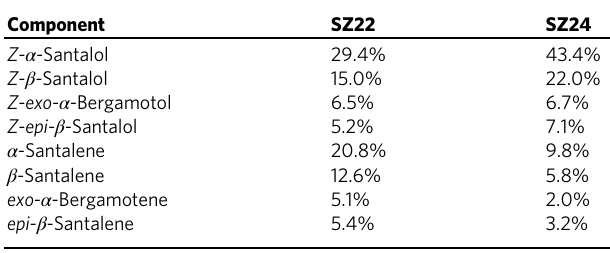
Table 1 The component ratios of the oils produced by SZ22 and